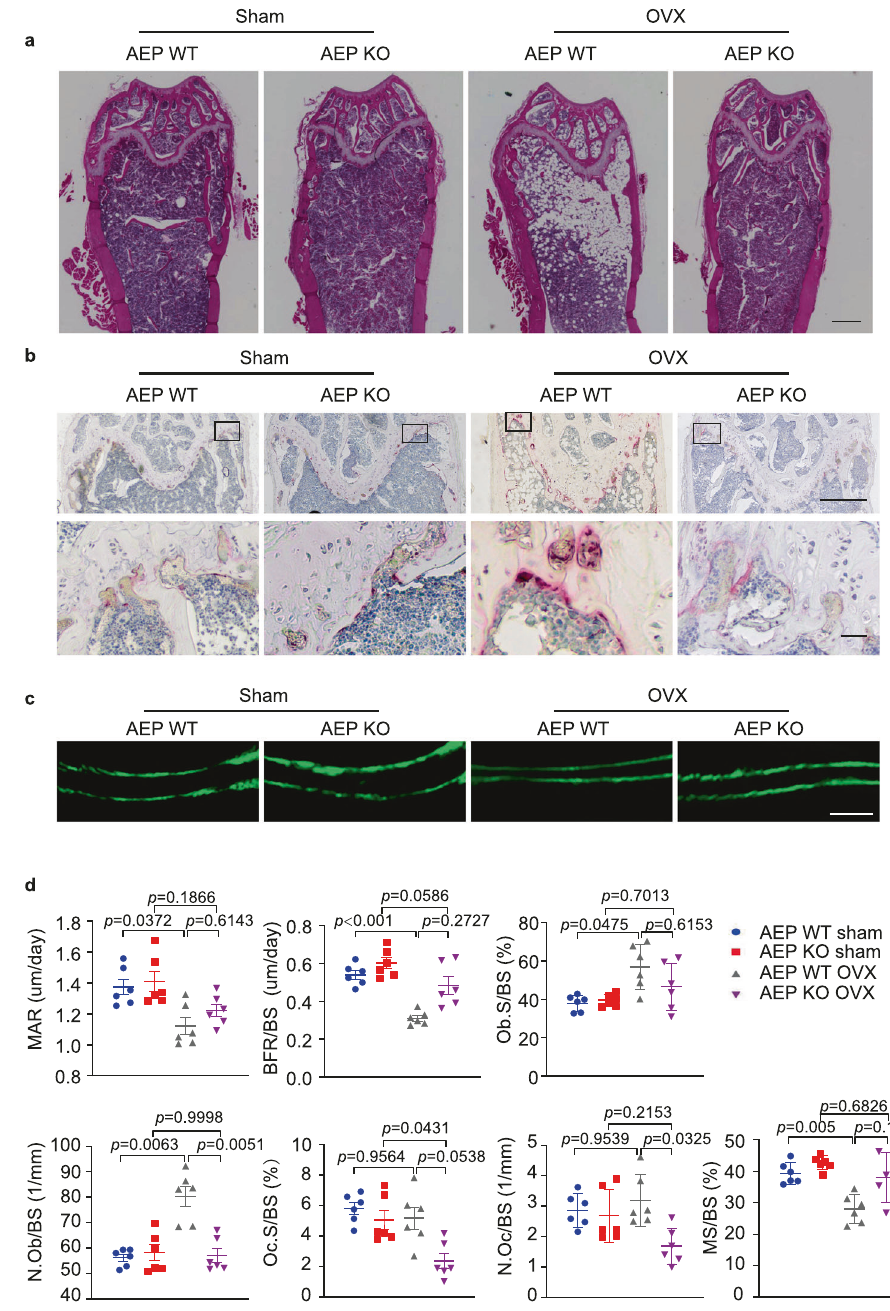
Fig. 2 | AEP knockout inhibits the bone turnover induced by ovariectomy in female mice.a Representative images of hematoxylin and eosin (H&E) staining of thedistalfemurboneinwild-type(AEPWT)andAEPknockout(AEPKO)micewith (OVX) or without (Sham)ovariectomy( n =5 mice pergroup). (Scalebar, 500 μ m). b Representative images of tartrate resistant acid phosphatase-stained (TRAP- stained)sectionsofthe distalfemur bone in AEPWTsham, AEPKO sham, AEP WT OVXandAEPKOOVXgroupatlowmagni fi cation(upperpanel)andaselectedarea (shown as the boxed region in the top row of images) at higher magni fi cation (lower panel) ( n =5 mice per group). (Scale bar, 500 μ m (upper panel), 20 μ m (lowerpanel)). c Micewereinjectedsubcutaneouslywithcalceinatday10andday 3 before sacri fi ce. Trabecular calcein double- fl uorescence labeling images (green) oftherepresentativesectionsinAEPWTsham,AEPKOsham,AEPWTOVXandAEP